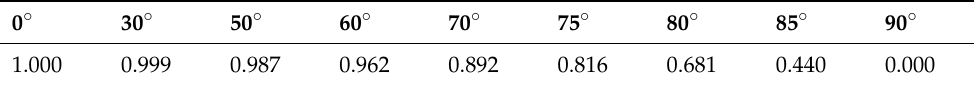
Table 3. Incidence effect (IAM) loss factor for two investigated